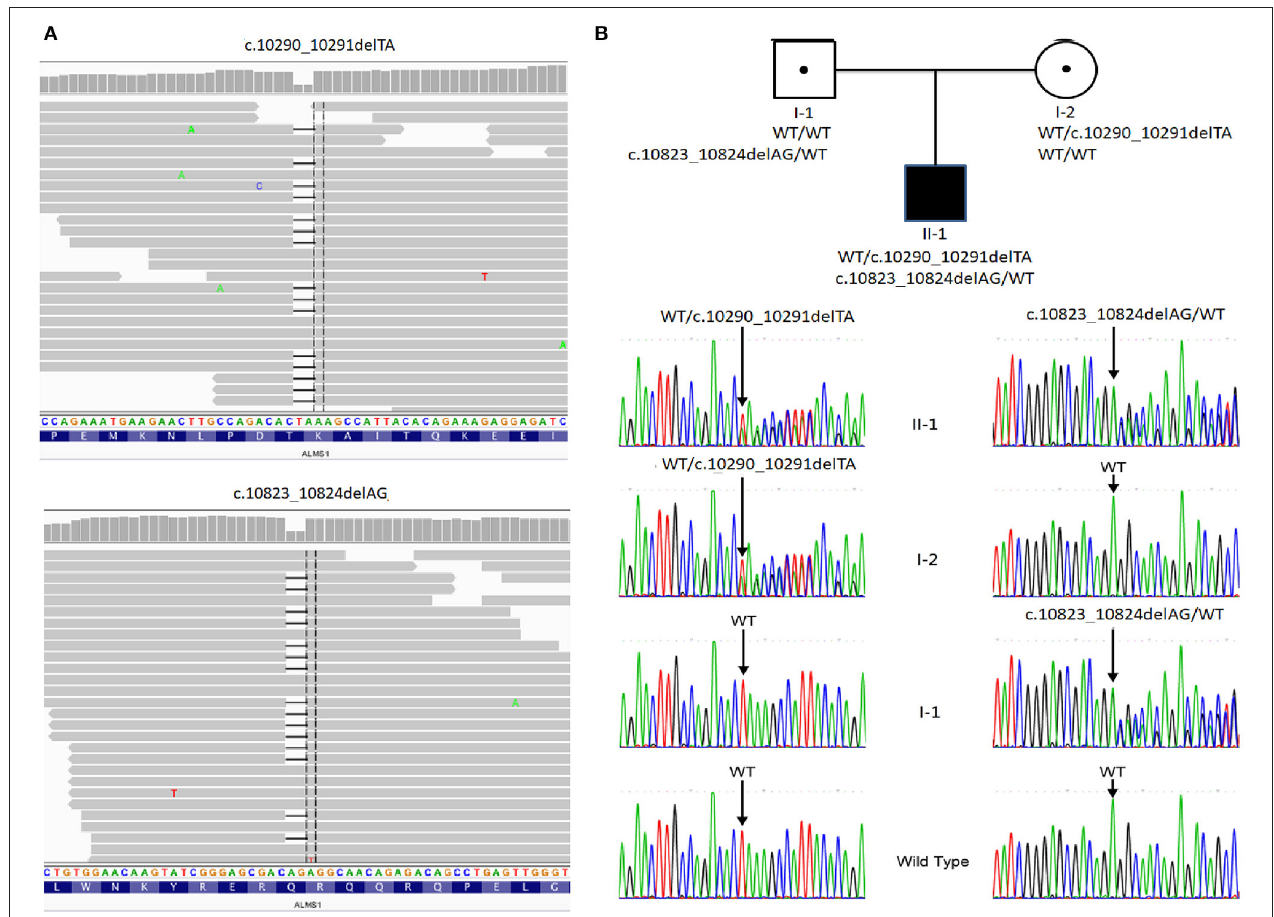
FIGURE 1 | Pedigree and mutation analysis of the family. (A) Alignment of exome sequences to Hg19 showing 2-base pair deletion in exon 15 and exon 16 of ALMS1 . (B) The proband (II-1) carried compound heterozygous mutations: c.10290_10291delTA inherited from his mother (I-2) and c.10831_10832delAG from his father (I-1). WT, wild